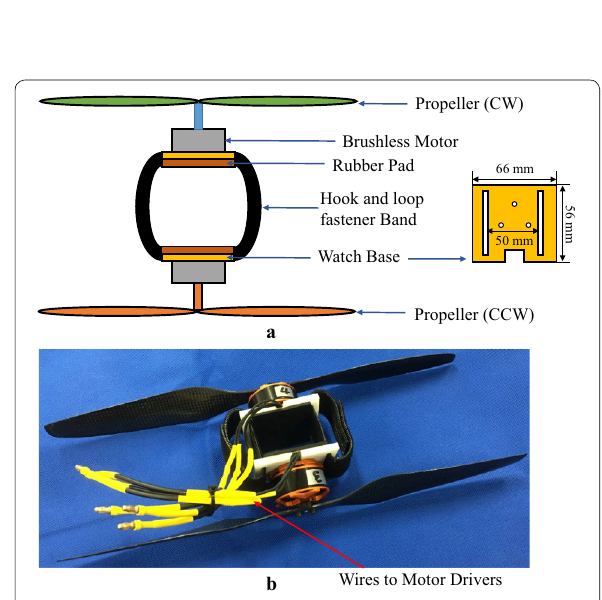
Fig. 4 a The design of a flying watch. b A prototype flying